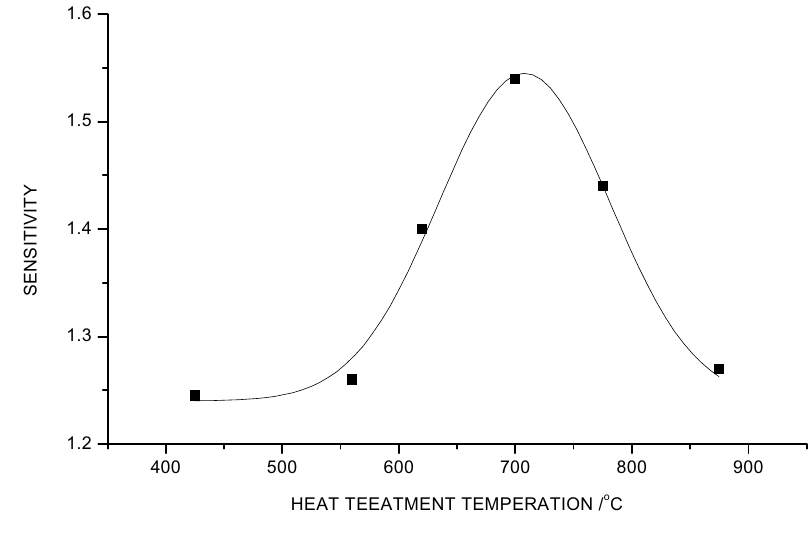
Figure 5. Relationship between sensor’s sensitivity and sintering